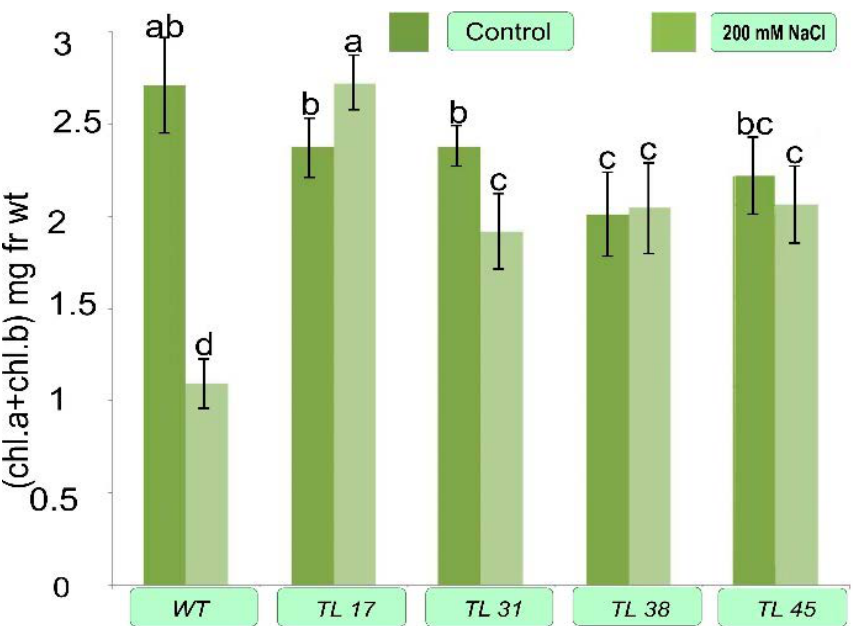
Figure 6. Glycine betaine content in transgenic plant lines. Control— medium Tc without adding NaCl; NaCl— medium Tc with the addition of 200 mmol NaCl. Columns with the same letters are not significantly different ( p ≤ 0.05, Duncan’s test).